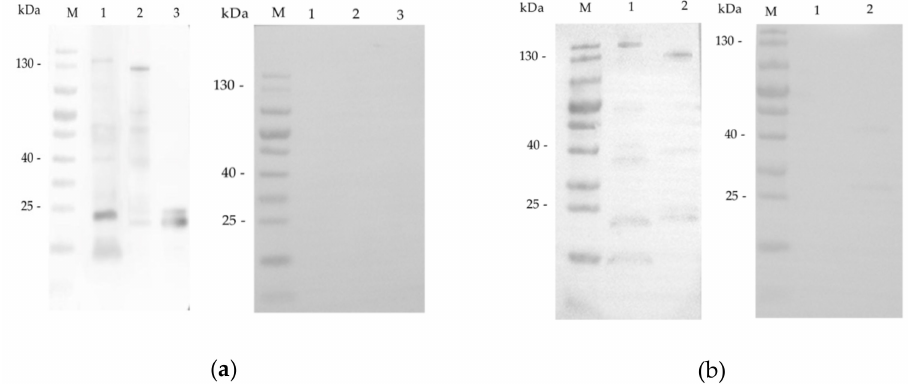
Figure 3. Expression of native INS-15 protein in C. parvum sporozoites. ( a ) Western blot analysis of native INS-15 protein in crude sporozoite extract in the presence of protease inhibitors using antibodies against the INS-15 domain I (left panel) and pre-immune serum (right panel). Lane M: molecular weight markers, Lane 1: native proteins from sporozoites, Lane 2: purified full-length recombinant INS-15 protein, Lane 3: purified INS-15 domain I. ( b ) Western blots analysis of native INS-15 protein using anti-INS-15 polypeptide antibodies (left panel) and pre-immune serum (right panel). Lane M: molecular weight markers, Lane 1: native proteins from sporozoites, Lane 2: purified full-length recombinant INS-15